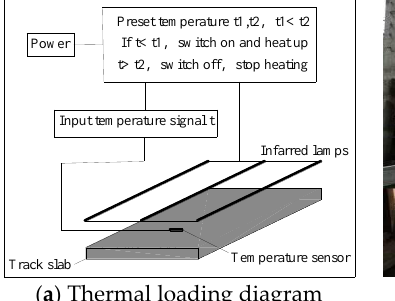
Figure 4. Thermal loading system.